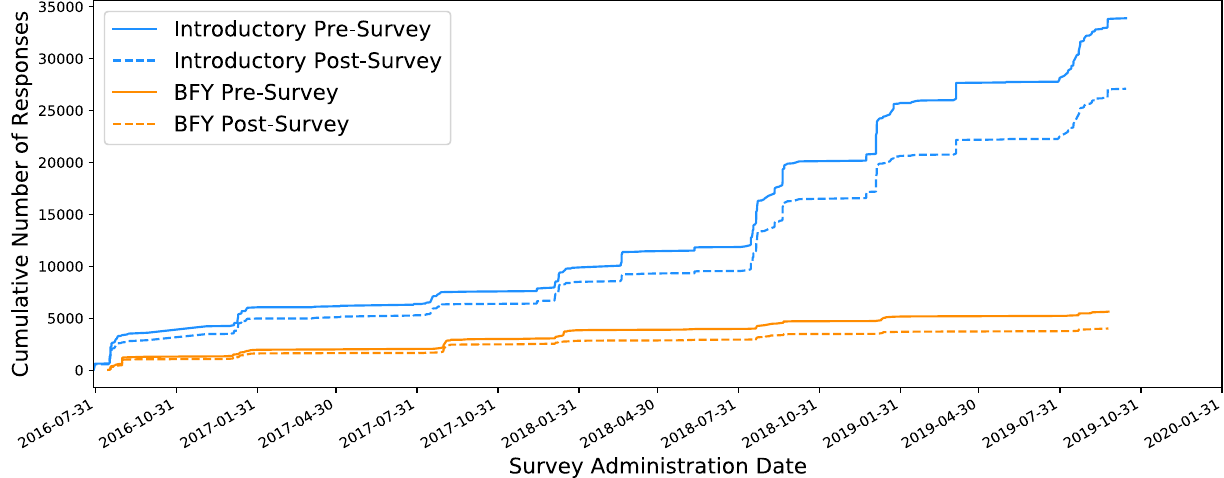
FIG. 2. Cumulative number of student responses to the E-CLASS since automated online administration began in 2016. More student responses are collected from introductory courses than BFY labs, as those classes tend to have larger enrollment. Additionally, in general, more students respond to the presurvey than the postsurvey, which accounts for the different between the two lines for each lab level. Currently, there are 70 598 total responses in the